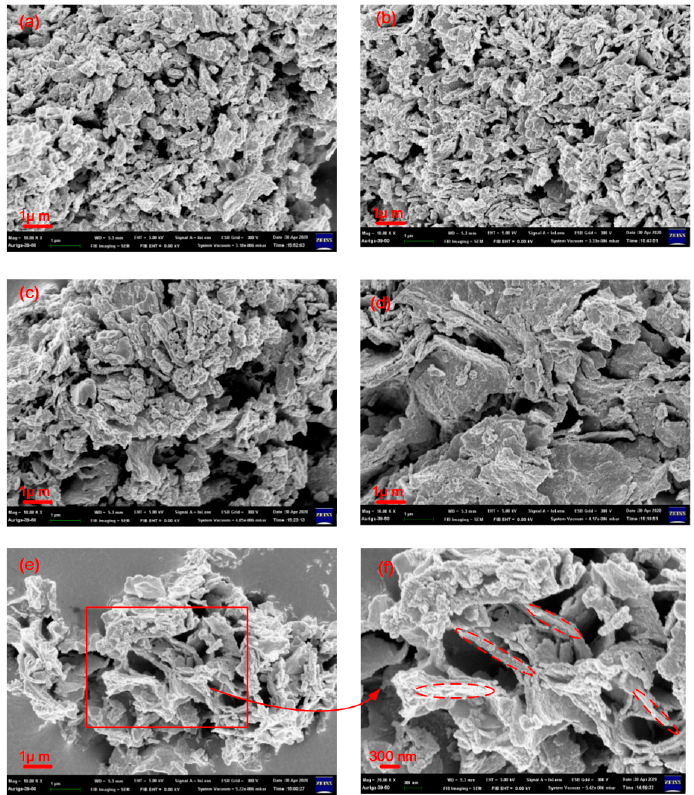
Figure 6. SEM micrographs of FeNCs: ( a ) 600A500, ( b ) 700600, ( c ) 800A700, ( d ) 900A800, ( e ) 1000A900, ( f ) enlarged image of 1000A900.